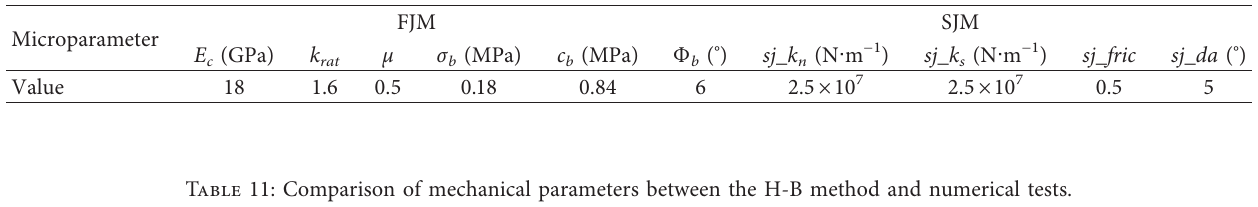
Table 10: The microparameters of engineering rock mass in the SRM model.